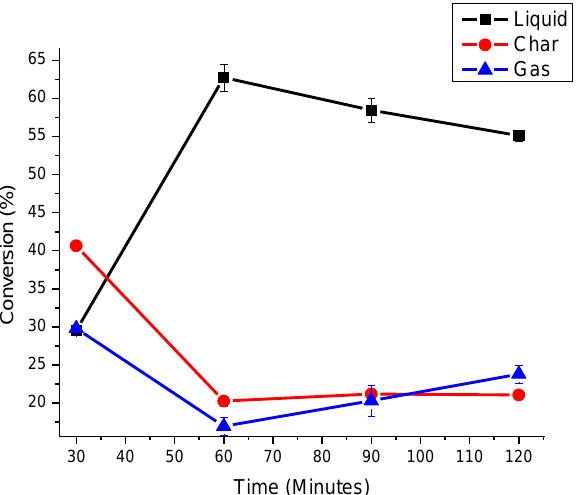
Figure 3. Heating Time and Rate Optimization for Catalytic Cracking of Tube Rubber.